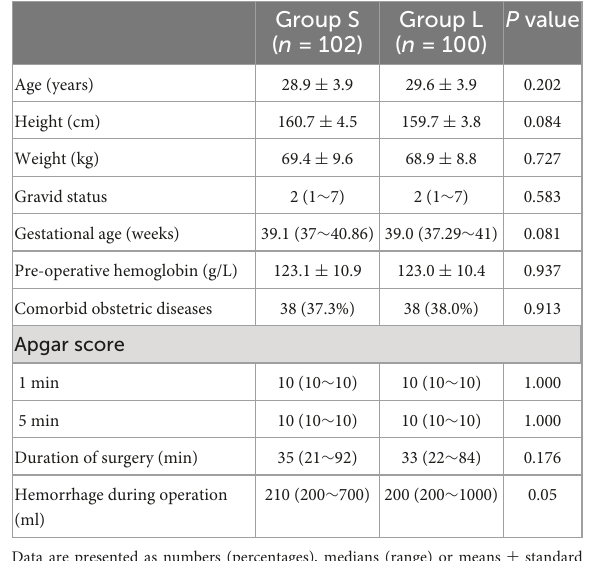
TABLE 1 Demographic data.